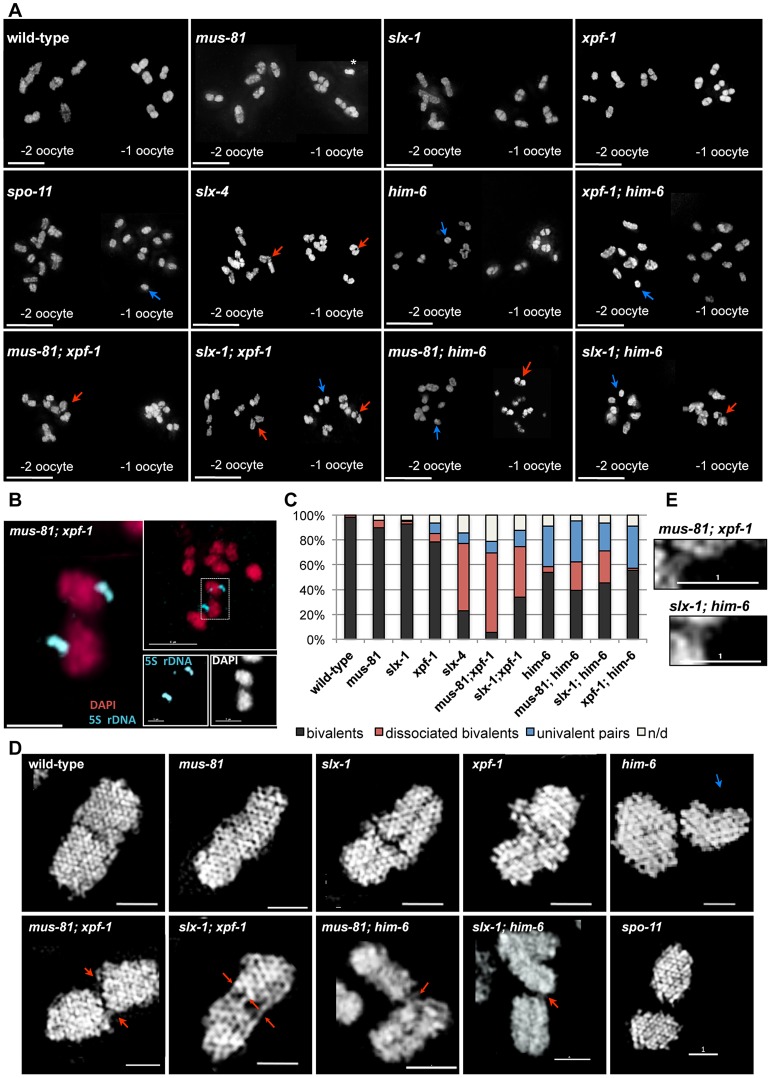
Evidence for DNA bridges linking homologous chromosomes in in [mus-81; xpf-1], [slx-1; xpf-1], [mus-81; him-6] and [slx-1; him-6] double mutants.(A) DAPI stained diakinesis chromosomes. Images represent projected Z-stacks obtained by deconvolution microscopy. Red arrows indicate thin chromatin bridges, blue arrows indicate univalents. The asterisk points to a sperm nucleus. Scale bars are shown in white (5 µm). (B) FISH analysis reveals that chromatin linkages occur between homologous chromosomes. Scale bars shown in white (2 µm). (C) Quantification of bivalents, ‘dissociated bivalents’ and univalents. 100% would reflect all oocytes scored containing six bivalents. A pair of ‘dissociated bivalents’ as well as two (unlinked) univalents are scored as one, in the respective categories. A minimum of 15 oocytes was scored for each genotype. Chromosomes often overlap in cytological preparations. In these cases chromosomes were scored as “n/d”. In addition, in mus-81, slx-1 and [xpf-1; him-6] in a very limited number of cases, fusions, which appear to occur between different chromosomes could be observed (Figure S1, data not shown, also see co-submitted paper by Saito et al.
[48]). (D) Images of representative chromosomes taken by super-resolution SIM microscopy. DNA bridges are indicated by red arrows. Scale bars are shown in white (1 µm). (E) Close up of DNA bridges obtained by SIM microscopy.